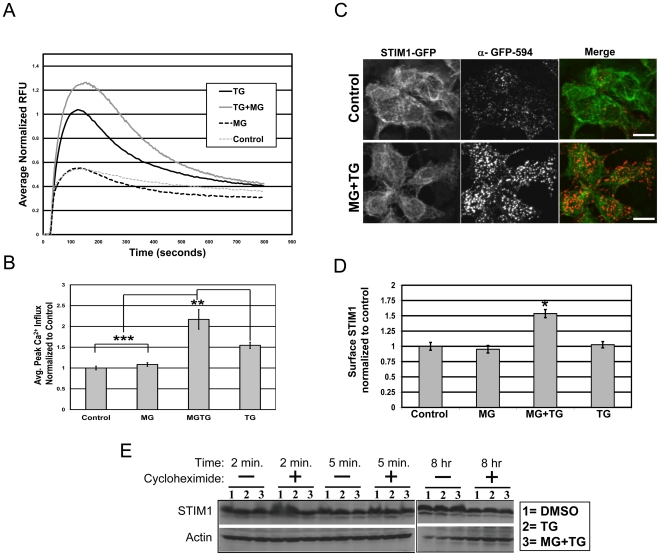
Effects of proteasome inhibition on store-operated calcium (SOC) influx, STIM1 subcellular localization and STIM1 stability.Potentiation of TG-induced calcium influx in HEK293 cells following pretreatment with the proteasome inhibitor MG-132 (10 µM). HEK293 cells plated in 96-well plates were loaded with the calcium indicator Fluo-4AM. Prior to loading the cells were pretreated with either vehicle (DMSO) or MG-132 (10 µM) for 1 h. The cells were then treated with 1 µM TG or vehicle (DMSO) for 30 min. Fluorescence was monitored by a FlexstationII 96-well fluorimeter, with Ca2+-re-addition (1.8 mM final) 5 minutes following baseline measurements. (A) Traces represent Ca2+-influx normalized to baseline, averaged over 12 wells per treatment. (B) Bar graph depicts averaged peak Ca2+ influx ± SEM. For statistical analysis, one-way ANOVA with post hoc Bonferroni's multiple-comparison test was used. *p<0.05; **p<0.01; ***p<0.001. (C) HEK293 cells expressing STIM1-GFP were treated as in (A), then live-labeled with α-GFP-Alexa 594 conjugated antibodies (red) prior to fixation. Scale bars, 10 µm. (D) Bar graph depicting the quantification of the STIM1-GFP surface levels from (D). Values were normalized to control. Mean values ± SEM are shown. * p<0.05, unpaired Student t-test. Represents the average of three independent experiments; 40 to 60 fields of cells per condition (15–25 cells per field). (E) HEK293 cells were treated in the absence (-) or presence (+) of cycloheximide (50 µg/mL) with either (1) DMSO, (2) 2 µM TG, or (3) 2 µM TG plus 10 µM MG-132 for the indicated times. Following treatments, protein levels were examined by western blot analysis with α-STIM1 or α-actin antibodies. Represents blots from 3 independent experiments.